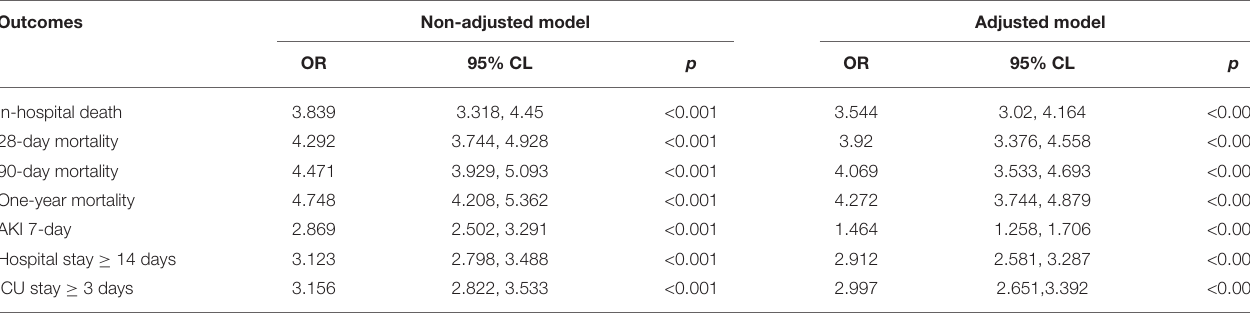
TABLE 5 | The logistics regression of SAPSII scoring system.